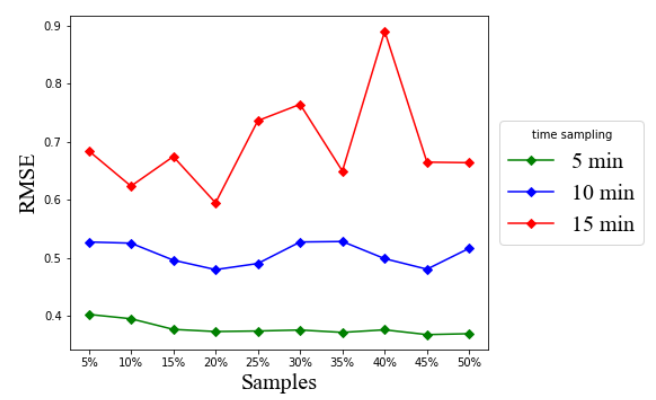
Figure 20. RMSE with varied time sampling.